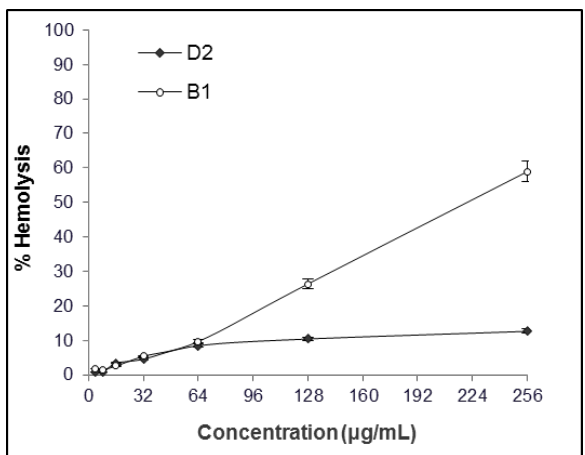
Figure 2. Hemolytic activity of peptide-peptoid hybrid B1 and peptoid D2 in human erythrocytes as a function of concentration. Mean ± SEM, n = 3.